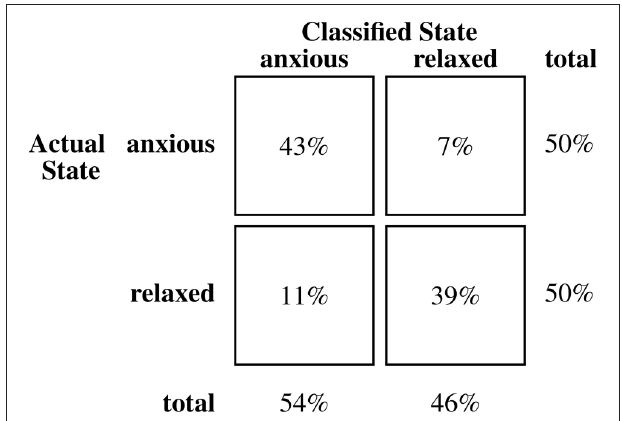
FIGURE 5 | Confusion matrix for classifications of biomusic from children with ASD in Experiment 2.